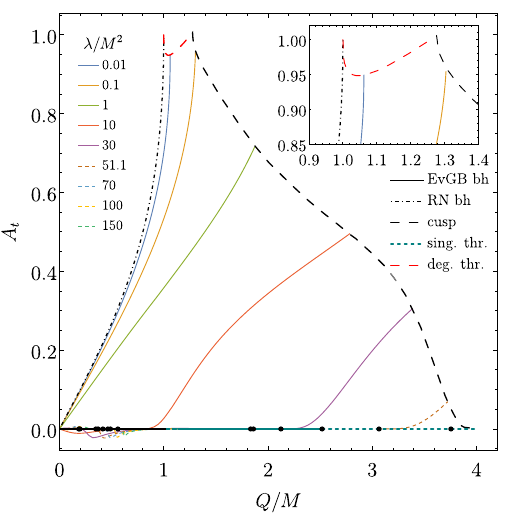
Fig. 11 Throatradiusvs.vectorcharge:Shownarewormholesolutions for coupling function (i)